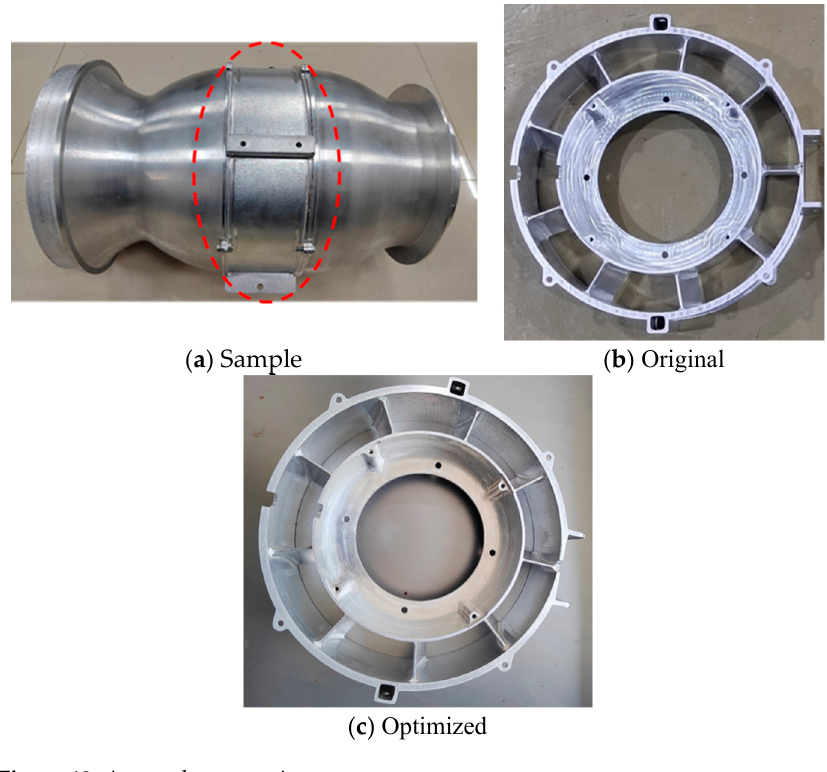
Figure 13. A sample